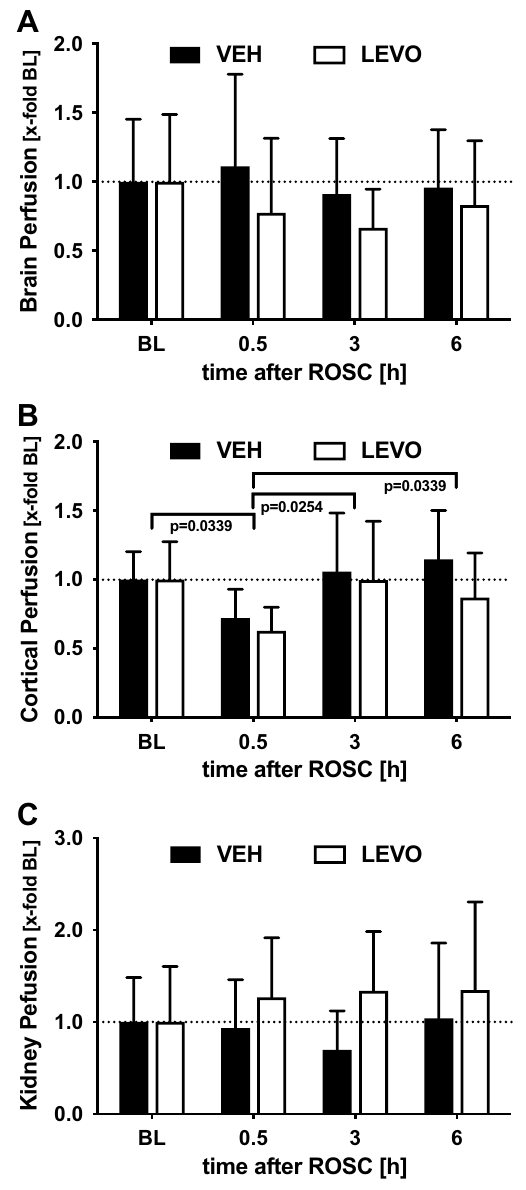
Figure 3. Cerebral and kidney perfusion. ( A ) Global cerebral blood flow was determined before and 0.5, 3, and 6 h after ROSC using fluorescent microspheres, and values were normalized to baseline values to correct for interindividual variation. ( B ) Cortical blood flow was measured with an epidural laser Doppler probe. ( C ) To show systemic perfusion, the kidney was selected as the index organ, and renal blood flow was measured using fluorescent microspheres. Although global brain and renal perfusion were not influenced by cardiac arrest (CA) or levosimendan treatment, brain cortical perfusion was significantly impaired 30 min after CA and returned to baseline levels at later time points. BL baseline, VEH vehicle, LEVO levosimendan. Statistics: repeated measures two-way ANOVA, followed by Šidák’s multiple comparisons test; data are presented as means ±